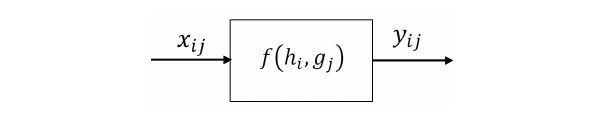
FIGURE 1 | Process unit i